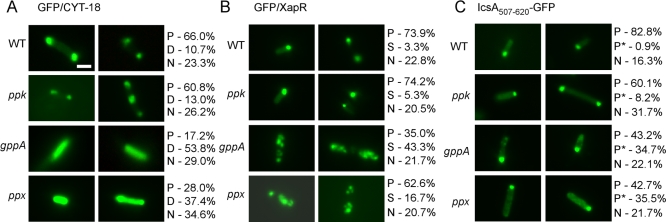
Disruptants that Accumulate Poly(P) Show Altered Intracellular Localization of Other Basic ProteinsFluorescence microscopy of wild-type HMS174(DE3) (WT) and the indicated disruptants containing (A) pAC-GFP/CYT-18, (B) pAC-GFP/XapR, or (C) pBAD24-icsA
507–620
::gfp. Cells were induced with (A and B) 500 μM IPTG or (C) 0.2% l-arabinose overnight at 30 °C. At least 200 cells were examined in each case, and the proportions of cells showing polar (P), diffuse (D), scattered (S), polar and dispersed tiny foci (P*), or no detectable poly(P) fluorescence above background (N) are indicated to the right. The localization patterns shown in the figure represent the most common pattern for each strain. Bar = 2 μm.